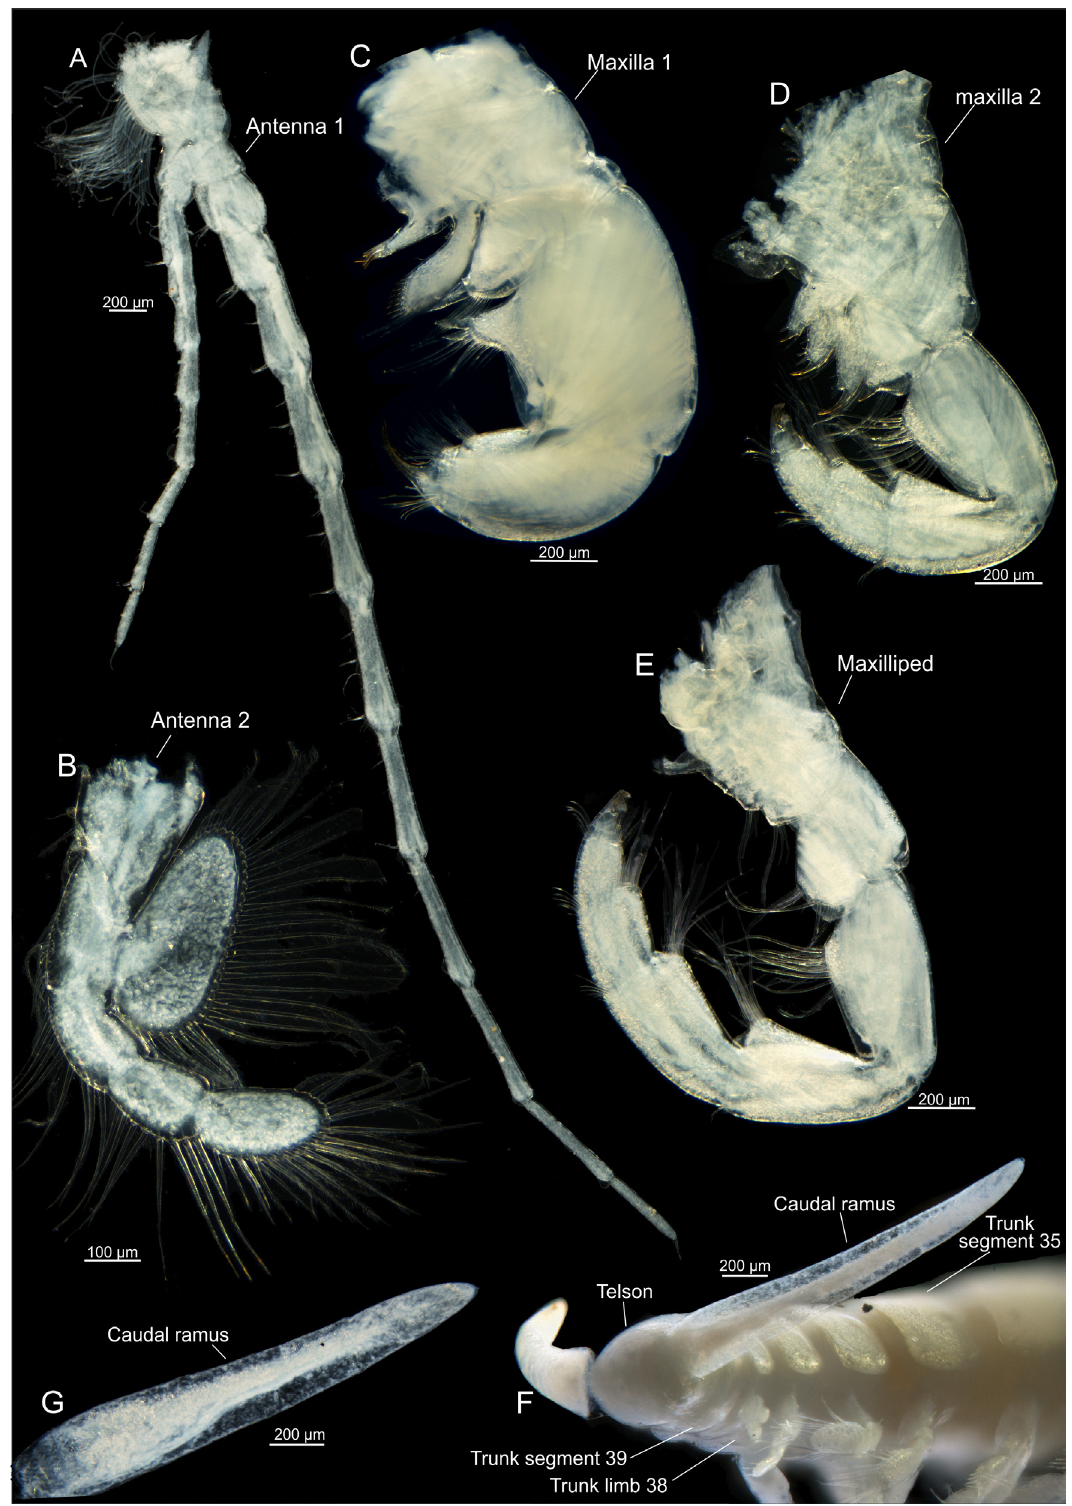
Fig. 4. Xibalbanus cozumelensis sp. nov., holotype (ZMUC-CRU-4791), light microscopy. A . Antenna 1, left side from anterior. B . Antenna 2, left side from anterior. C . Maxilla 1, left side from anterior. D . Maxilla 2, left side from anterior. E . Maxilliped, left side from anterior. F . Caudal rami and posterior part of trunk. G . Caudal ramus, left side seen from